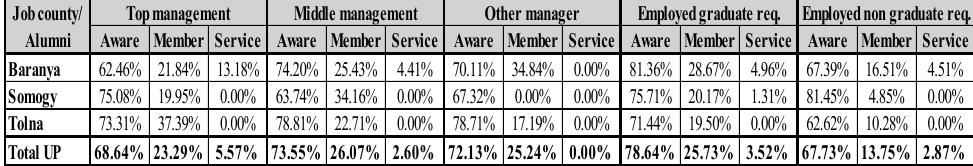
Table 5. The graduates’ Alumni related information (awareness, membership, service used) by the job position in the South-Transdanubian region (n=1,251).